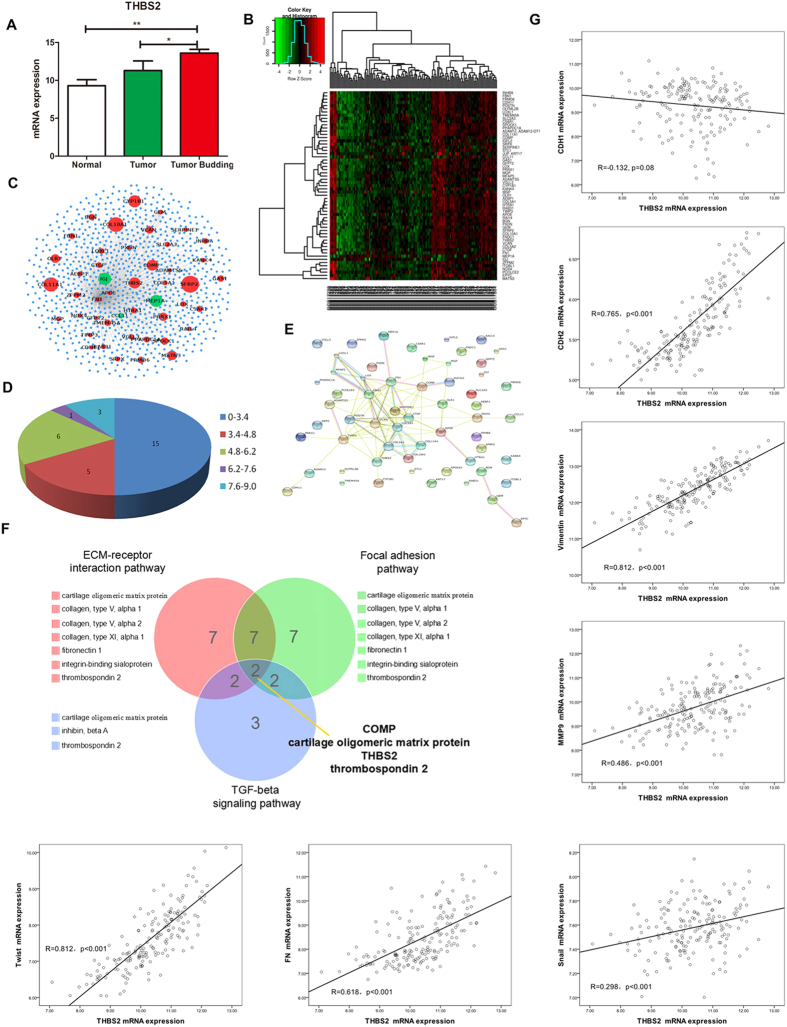
(A) The expression of THBS in normal, tumor and tumor budding in CRC. (B) Hierarchical clustering of colorectal cancer samples. A green-red heat map was used to represent up- and down-regulated genes visualize the clustering results. (C) Protein-protein interaction (PPI) networks of differentially expressed genes (DEGs). (D) DEGs degree distribution. (E) The interaction of protein by string. (F) Pathway enrichment. (G) The correlation between THBS2 with EMT marker.